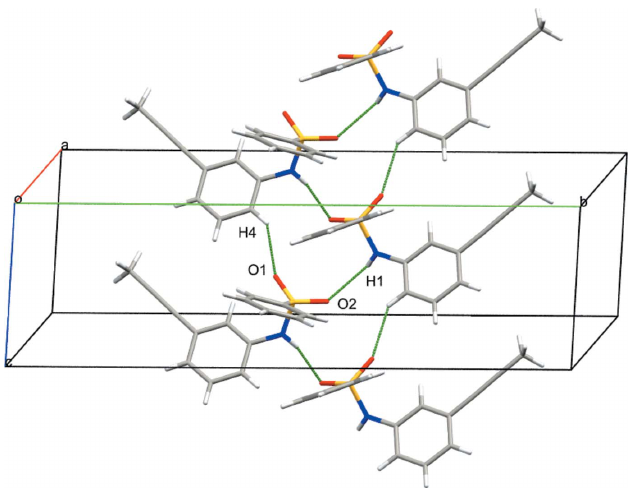
Figure 2 Part of an [001] hydrogen-bonded chain with N—H (cid:3)(cid:3)(cid:3) O2, C—H (cid:3)(cid:3)(cid:3) O1 hydrogen bonds shown as green lines.